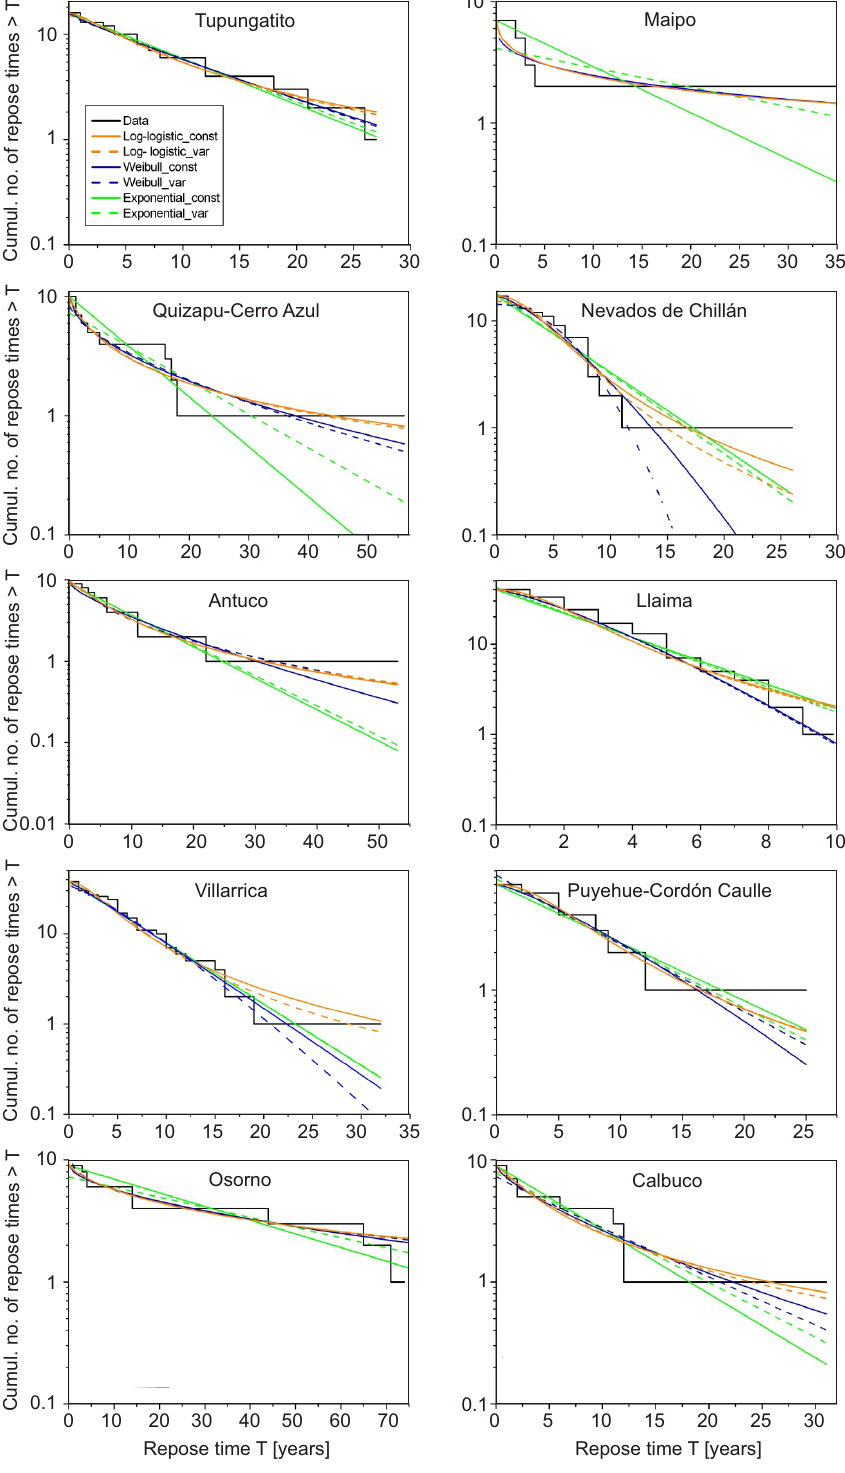
Fig. 5. Repose time distribution for the SVZ volcanoes (restricted eruption records where appropriate), with fits for the exponential (green), Weibull (blue) and log-logistic (orange) distribution functions. Fits for fixed scale A are displayed as solid lines, for variable A in dashed